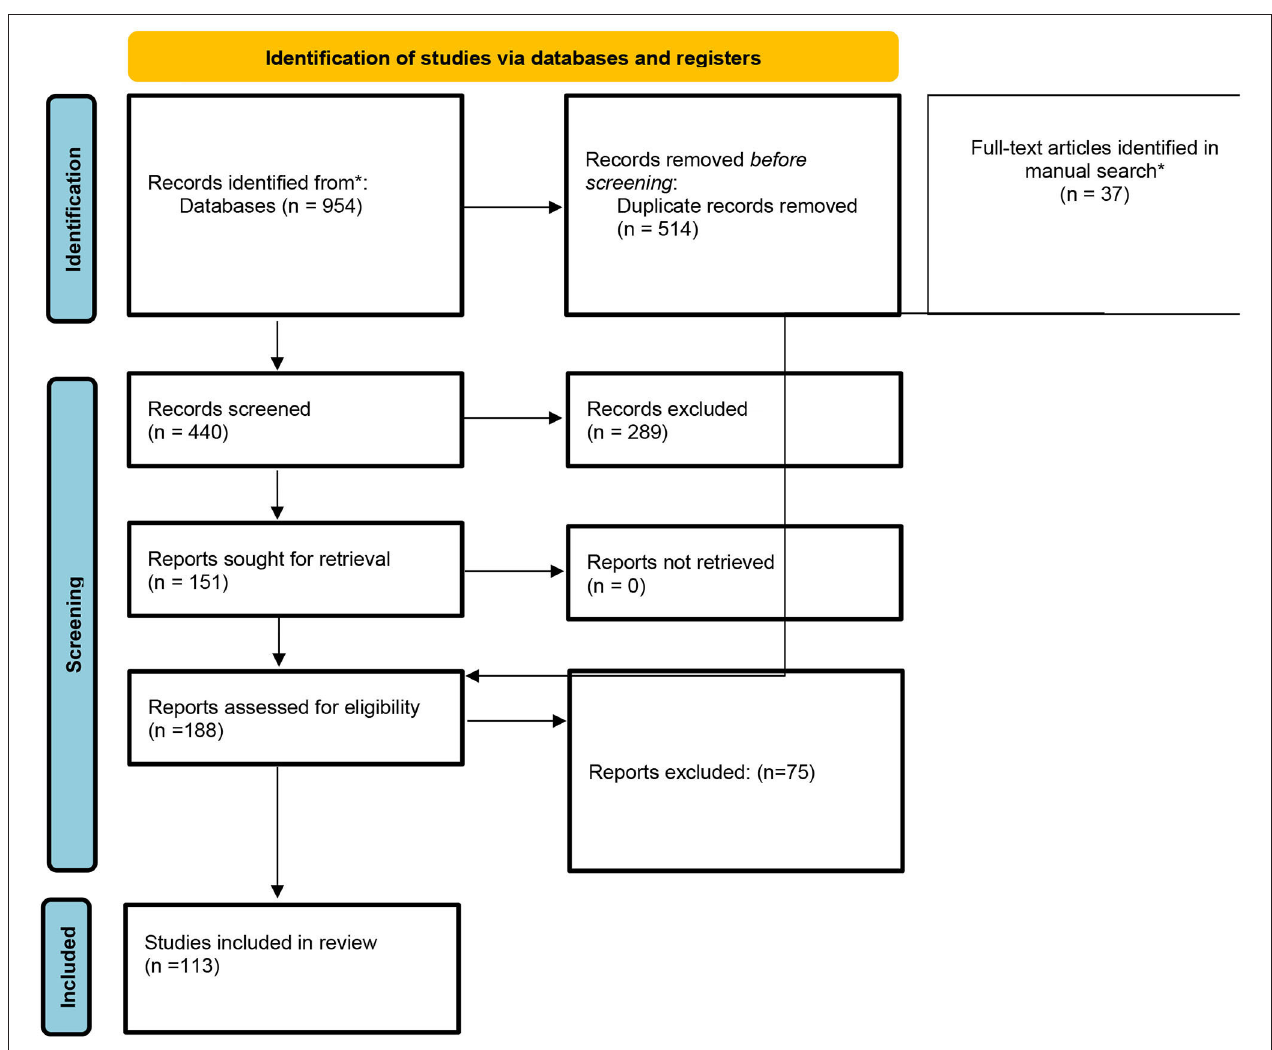
FIGURE 1 | PRISMA diagram. *Records identified from the references of full-text